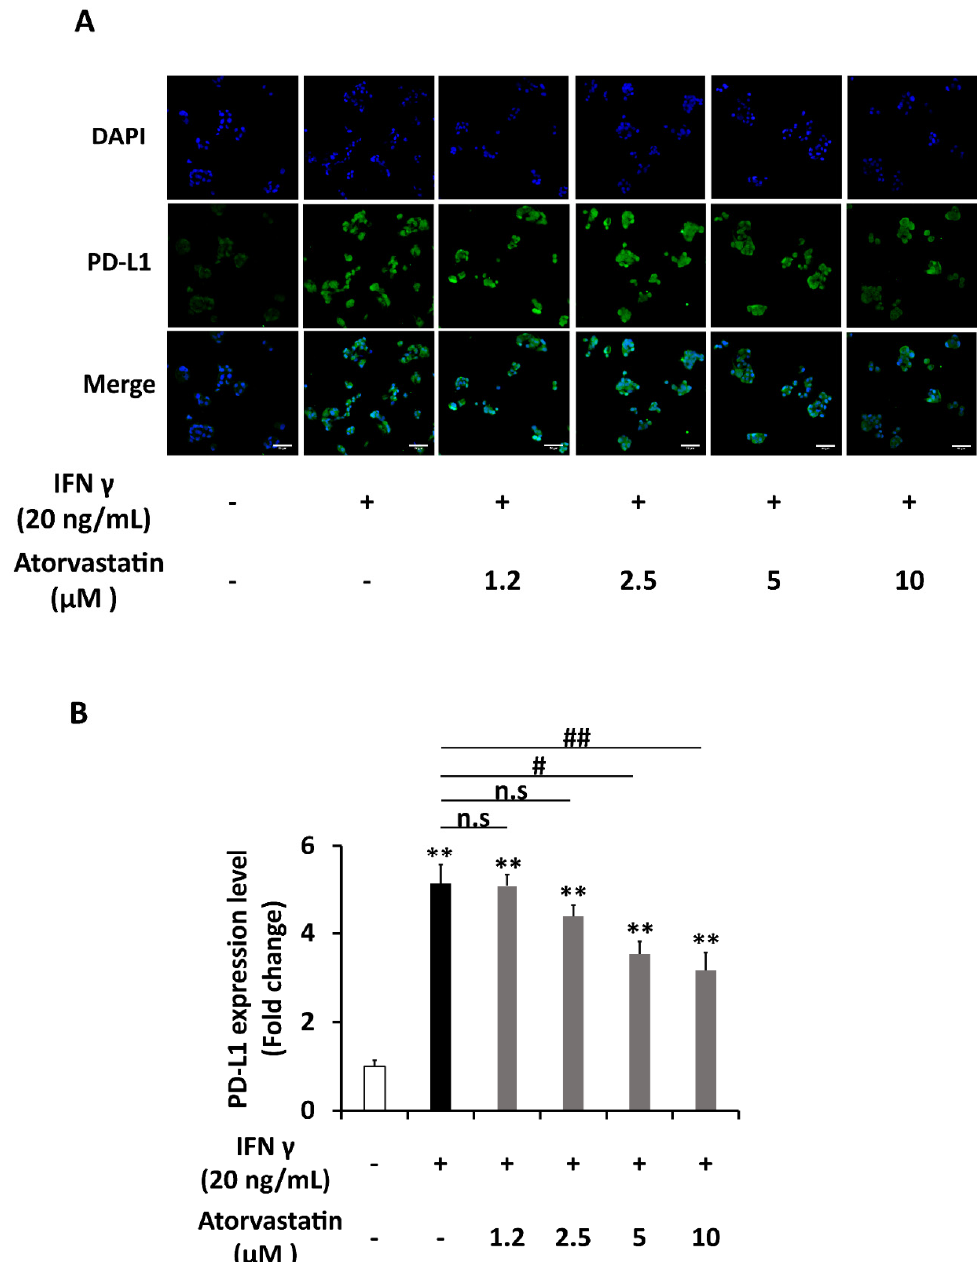
Figure 7. Atorvastatin mitigate the effect of IFN γ on upregulation of PD-L1 expression in HepG2 cells. ( A ) Representative figure and ( B ) quantification of immunocytochemistry analysis of PD-L1 membrane expression in HepG2 cells co-treated with IFN γ 20 ng/mL and atorvastatin at various concentrations ( µ M) for 24 h. Scale bar = 50 µ m. Data are presented as mean ± SEM. n = 3. * p < 0.05, ** p < 0.01 compared to control. # p < 0.05, ## p < 0.01 compared to IFN γ